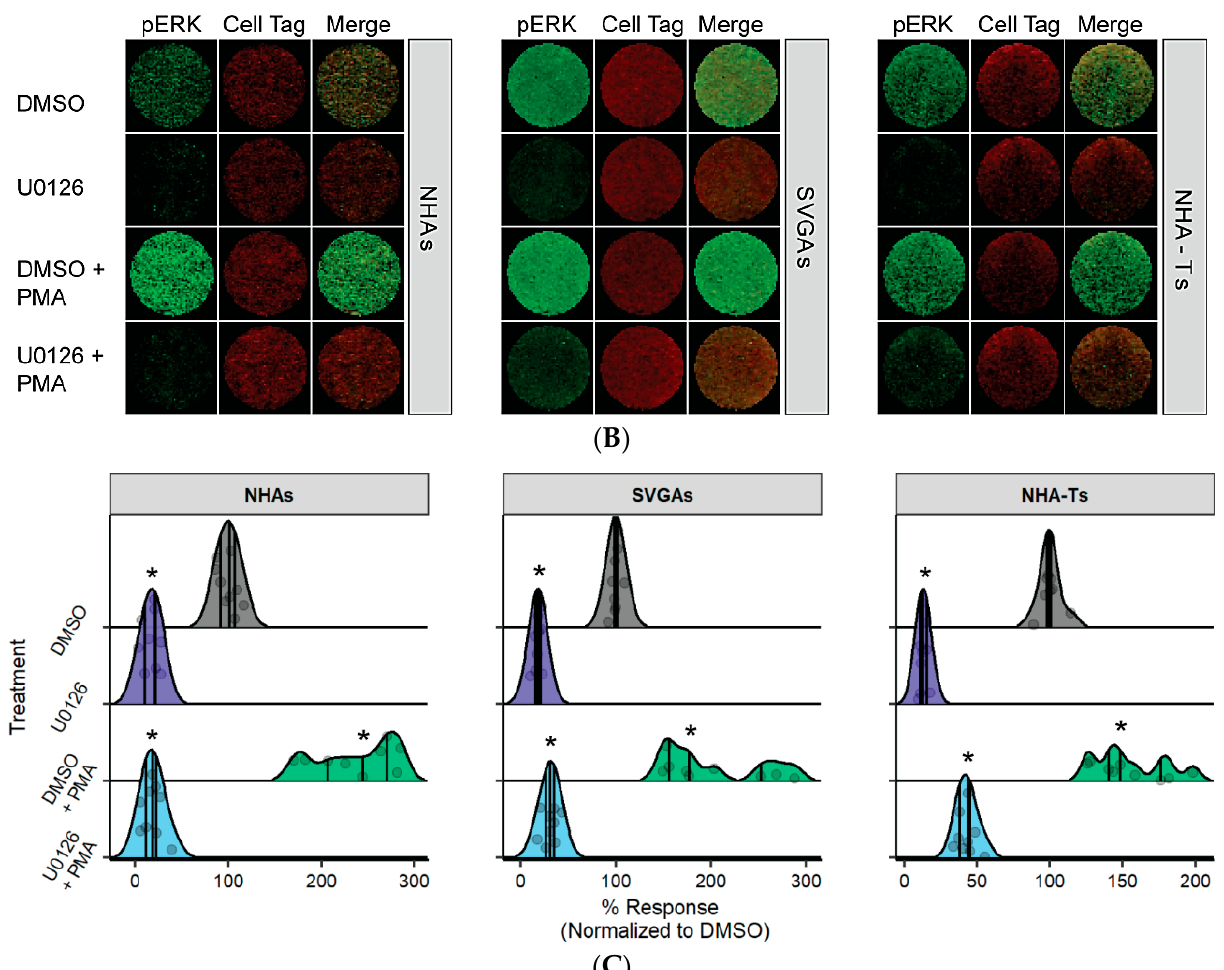
Figure 1. MEK inhibitor U0126 does not decrease JCPyV infection in NHAs. ( A ) NHAs, SVGAs, and NHA-Ts were pretreated with the MEK inhibitor U0126 at 10 µ M or DMSO at an equivalent volume control and then infected with JCPyV (MOI = 2.0 FFU/cell; A , top) or SV40 (MOI = 2.0 FFU/cell; A , bottom) at 37 ◦ C for 1 h. Cells were incubated in media containing DMSO or U0126 for 48 h and then fixed and stained by indirect immunofluorescence. Percent infection was determined by counting the number of JCPyV T Ag- or SV40 VP1-positive nuclei divided by the number of DAPI-positive nuclei for five × 20 fields of view for triplicate samples. Data is representative of three individual experiments. Error bars indicate SD. Student’s t test was used to determine statistical significance comparing DMSO to U0126, with each cell type and viral protein. *, p < 0.01. ( B ) NHAs, SVGAs, and NHA-Ts were pretreated with DMSO or U0126 for 1 h in addition to PMA (40 nM) treatment of the indicated wells for the final 5 min at 37 ◦ C. Cells were fixed and stained for pERK (green) or CellTag (red). ( C ) Percentage of pERK for each treatment was quantitated by In-Cell Western signal intensity values per [(pERK)/Cell Tag × 100% = % response] within each ICW analysis with LI-COR software (representative image shown in B ). Density ridgeline plots represent the distribution of samples (individual points) with the lower quartile, median and upper quartile denoted as black lines in each distribution. Colored points represent individual points for each treatment (3 replicates, performed in triplicate). A Kruskal–Wallis test, along with the Bonferroni adjustment, was used to compare treatments in each cell type; however, only significance with the DMSO treatment versus other treatments are illustrated. *, p < 0.01. Data are representative of three independent experiments performed in